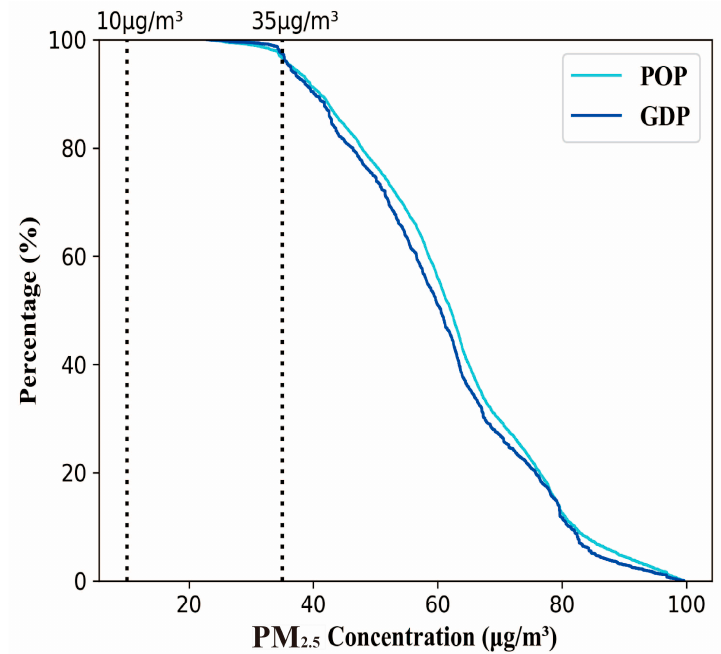
Figure 5. Cumulative distribution of annual mean PM 2.5 in mainland China for 2014 refer to the WHO air quality guidelines (AQG) of 10, and 35 µ g/m 3 . POP stands for population.